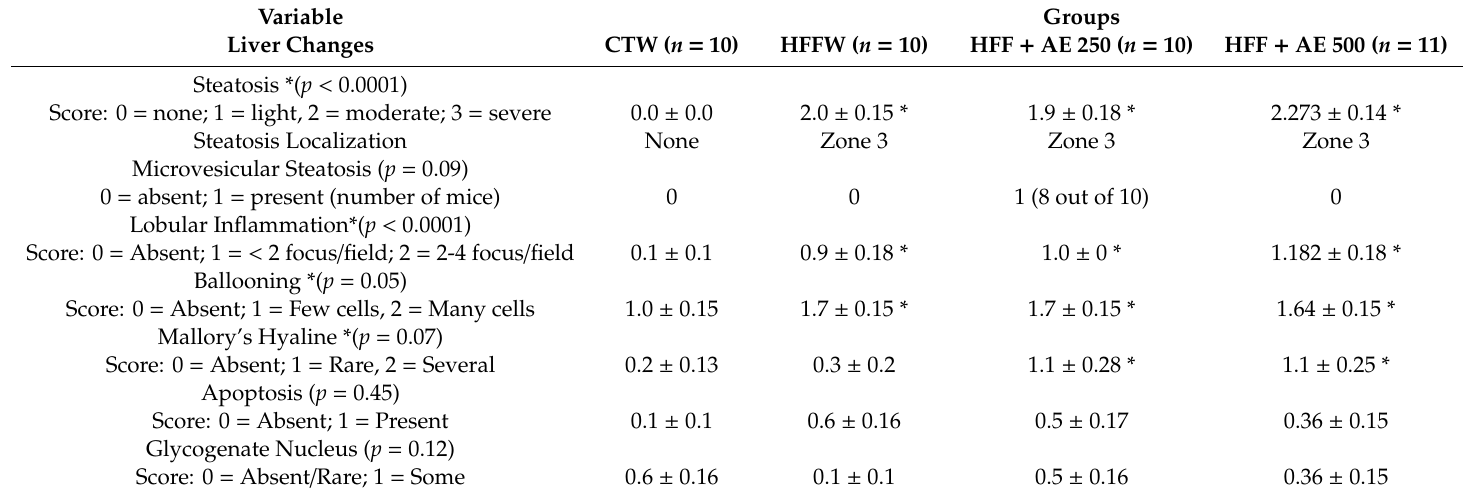
Table 4. Results for the changes observed in the livers of animals from each experimental group.